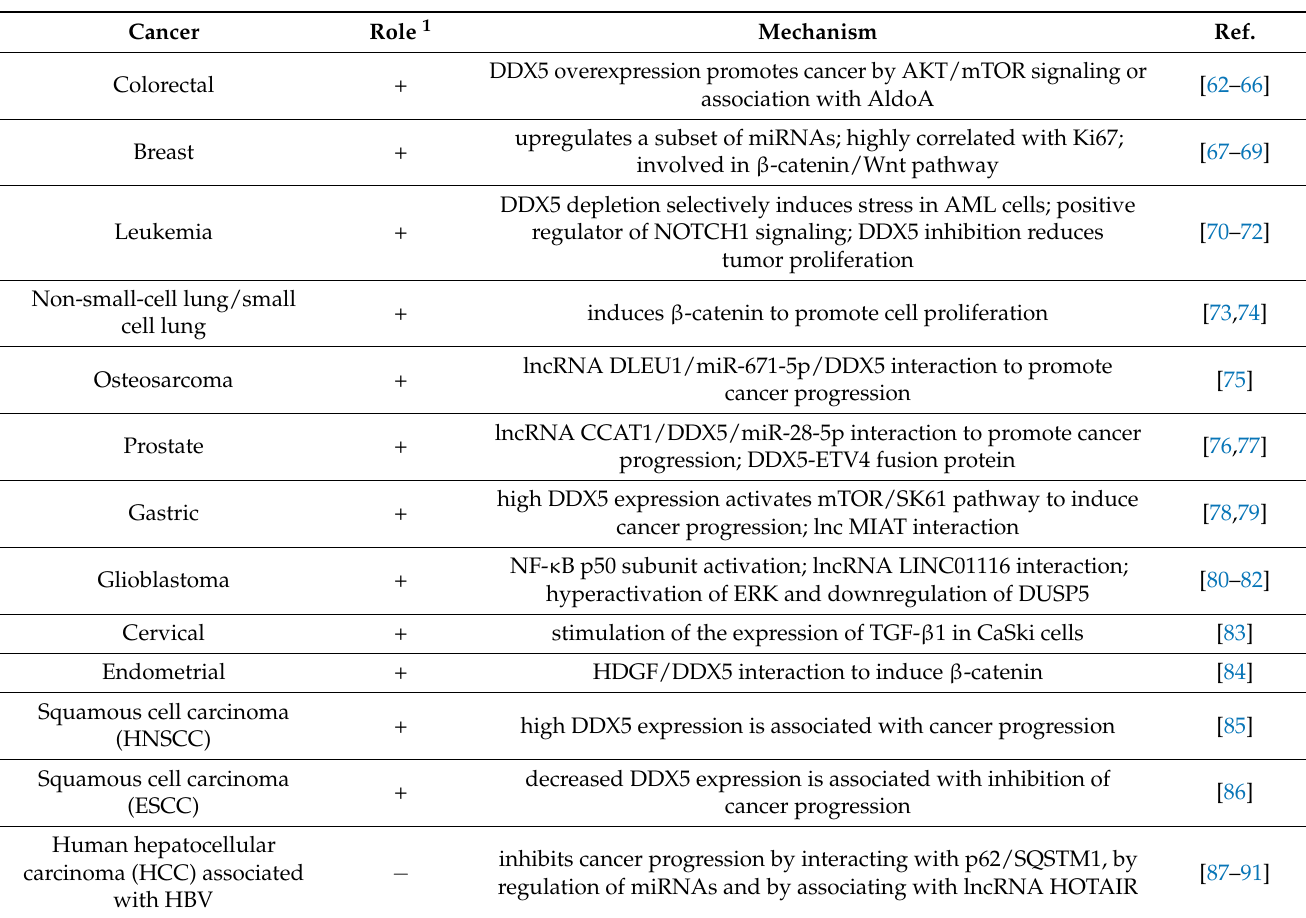
Table 2. Role of DDX5 in